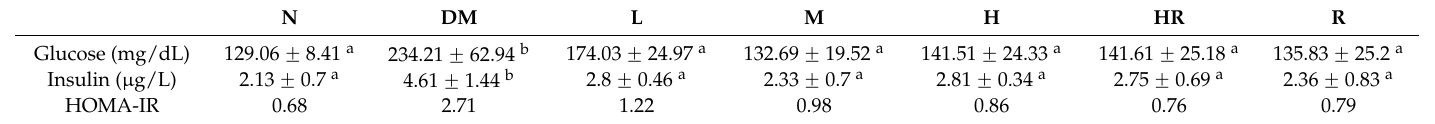
Table 1. Influence of red guava on blood glucose, insulin, and insulin resistance.